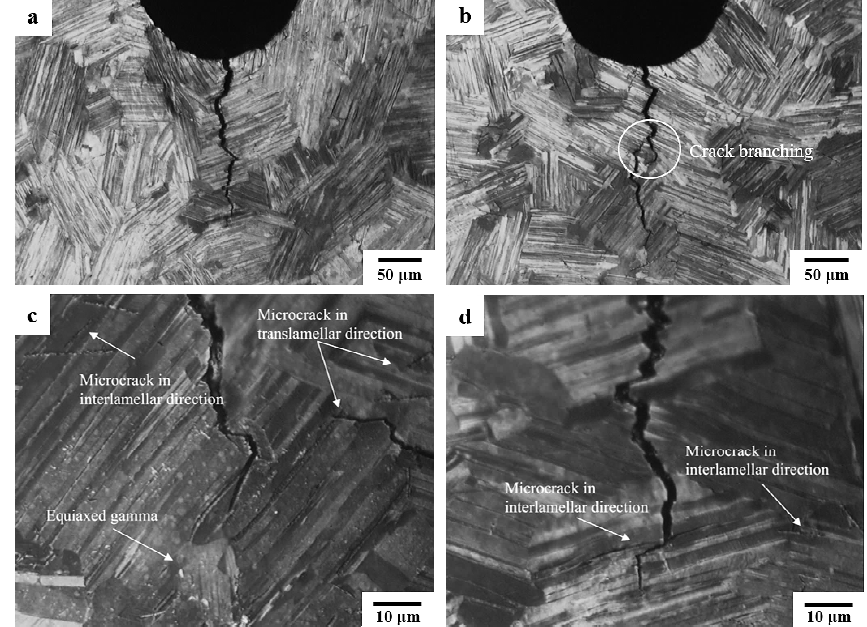
Figure 9. Optical images show a precrack in the SENB specimen generated by far-field cyclic compression load and heat tinted at 700 °C: ( a , b ) show the two side surfaces containing the precrack, and ( c , d ) show the details of microcracks found along the